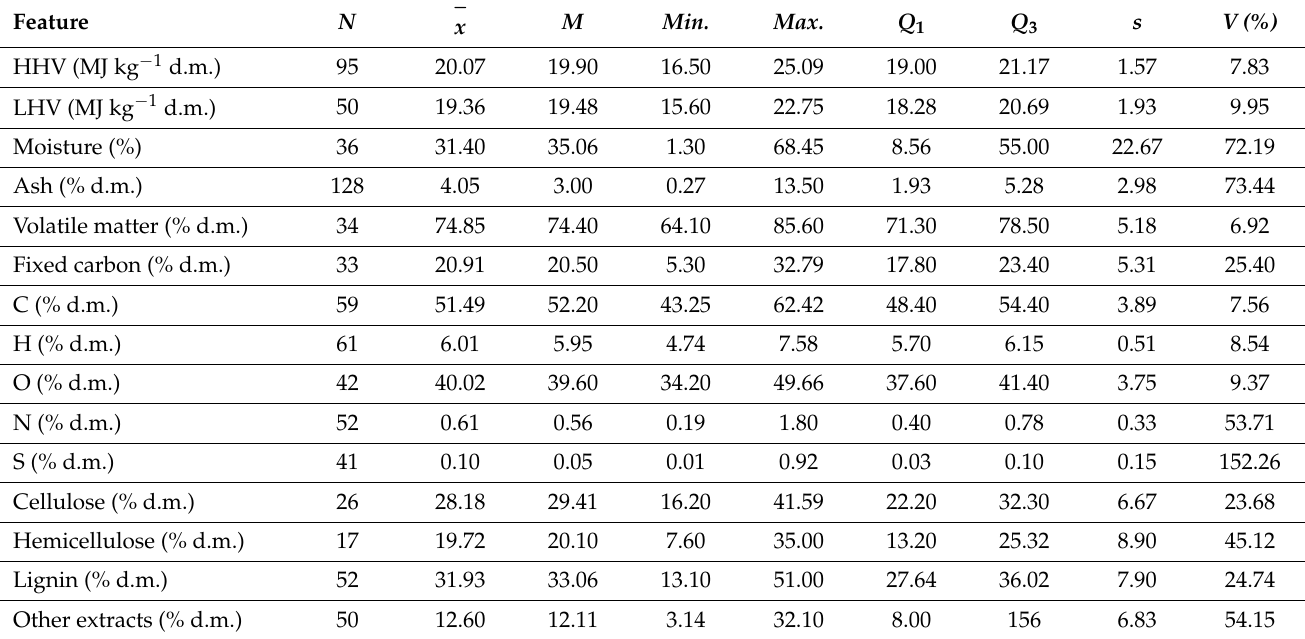
Table 7. Differentiation of thermophysical properties and elemental composition of bark without differentiation by type.